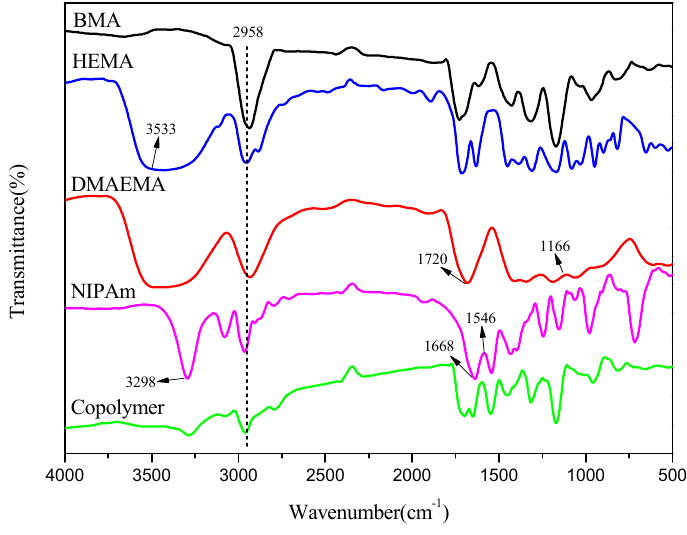
Figure 8. FTIR spectra of BMA, HEMA, DMAEMA, NIPAm and copolymer.